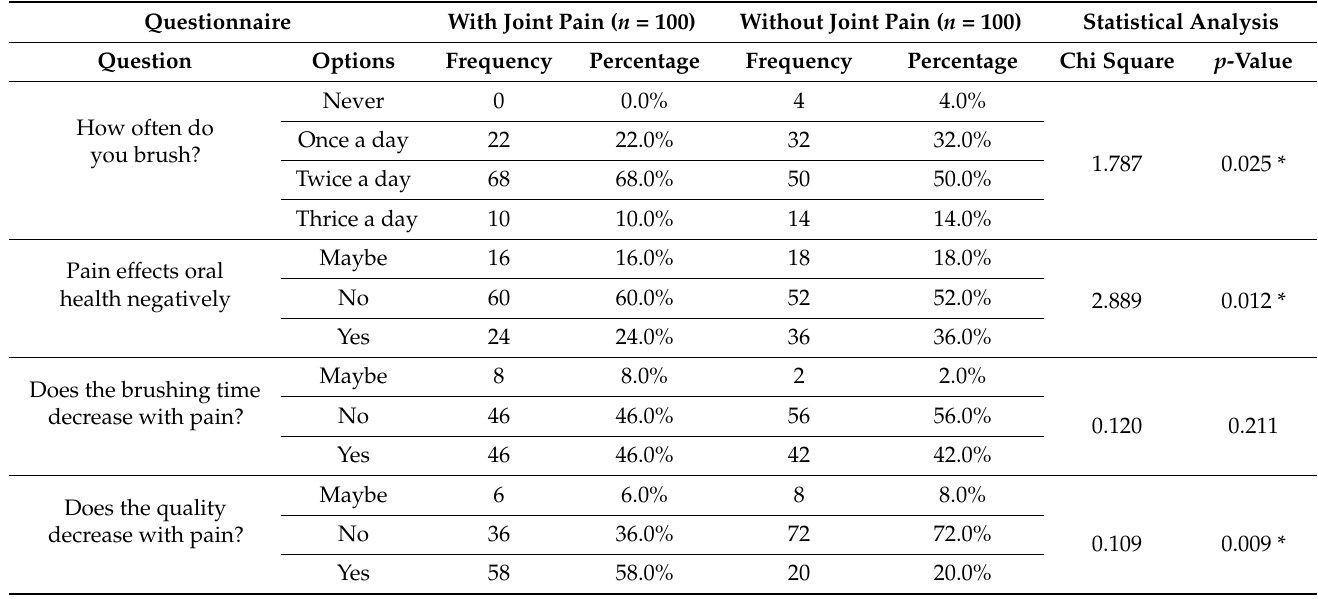
Table 1. Distribution of study subjects in both the groups according to the questionnaire.